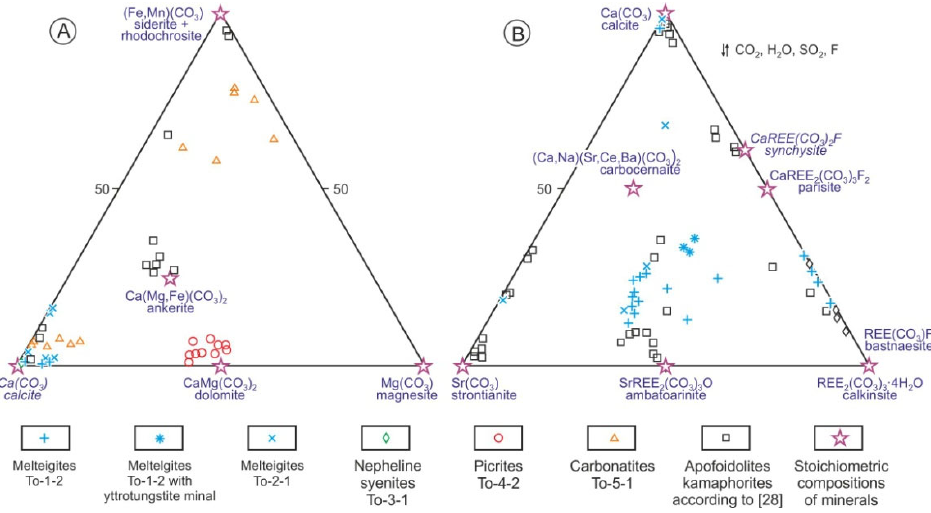
Figure 6. Compositions of main carbonate minerals ( A ) and rare carbonates of Sr and REE ( B